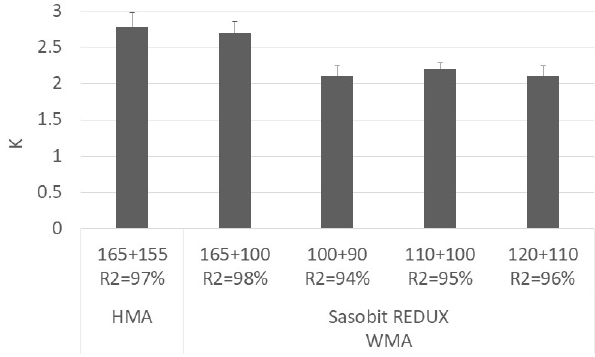
Figure 12. Figure 12. Variation of K parameter with mixture and temperature and corresponding squared- correlation values.